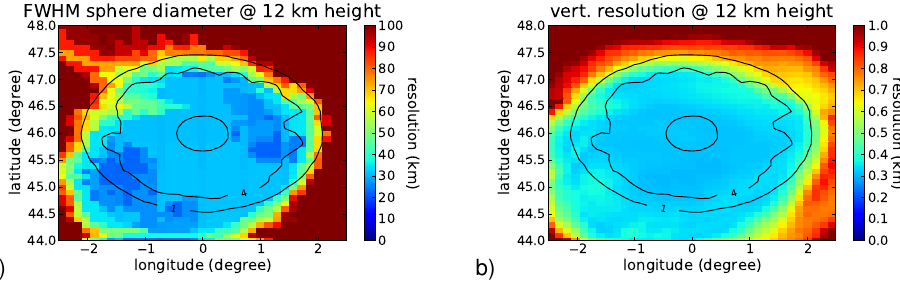
Fig. 14. Horizontal and vertical resolution of a retrieval with perfect wind speed knowledge. Panel (a) shows the FWHM sphere diameter and panel (b) shows the vertical resolution. The number of tangent points within the volume element is overlaid as a contour plot. other hand, in the southern part of the circle, the forward and backward looking measurements are taken only 30